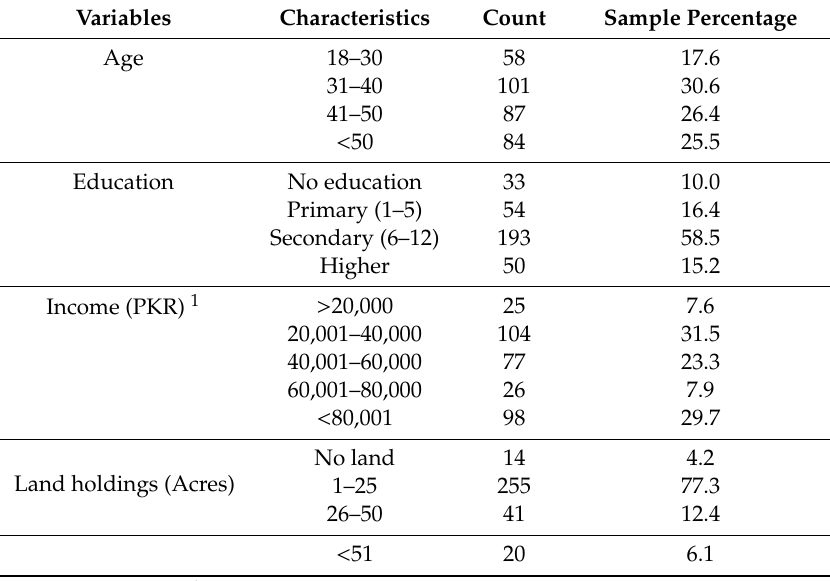
Table 1. Socio-economic and demographic characteristics of the study sample ( N =